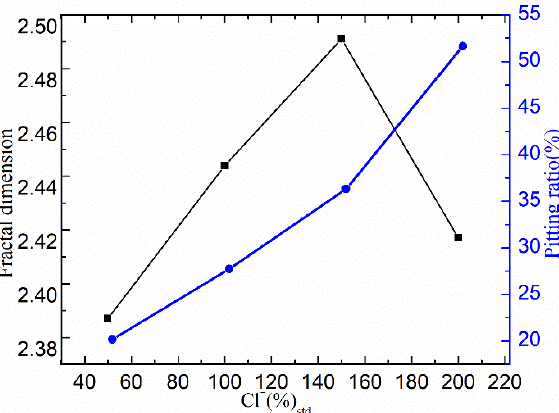
Figure 7. Relationship between pitting ratio and fractal dimension at different Cl − concentrations .